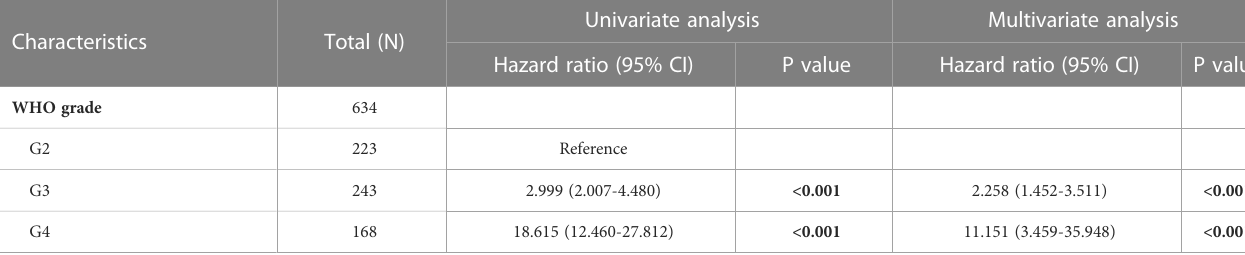
TABLE 1 Univariate and multivariate Cox regression analyses of clinical characteristics associated with OS of glioma.